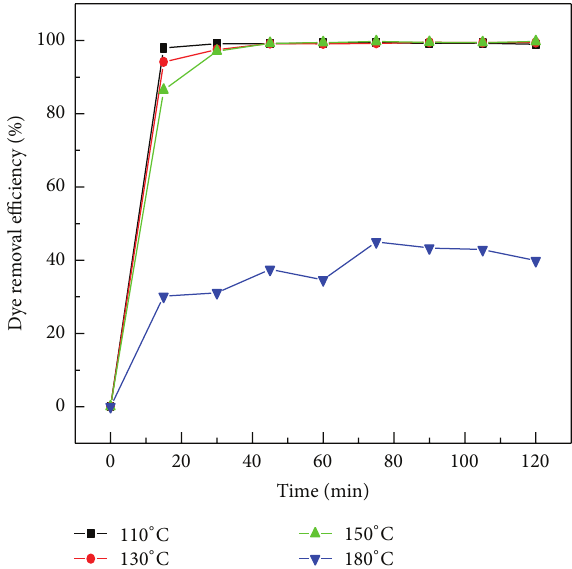
Figure 11: Dye degradation (%) by the as-prepared